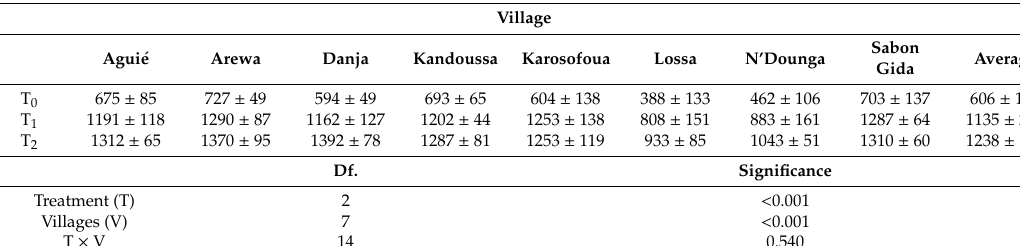
Table 7. The effect of the treatments on grain yield in eight on-farm experiments in 2019. (kg ha − 1 ). Average of treatments and corresponding 95% confidence intervals are presented.